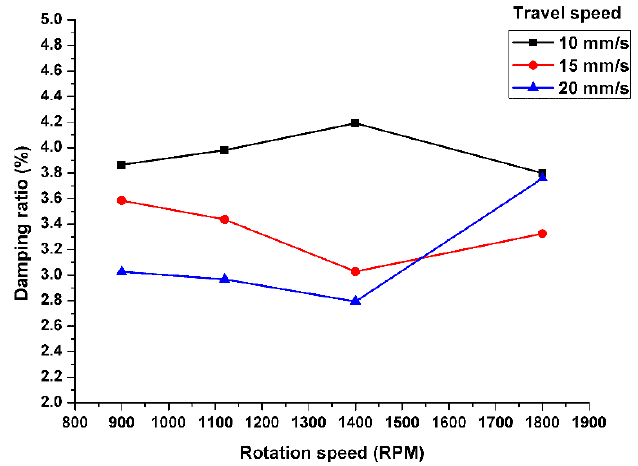
Figure 11. Effect of travel speed on the damping capacity.